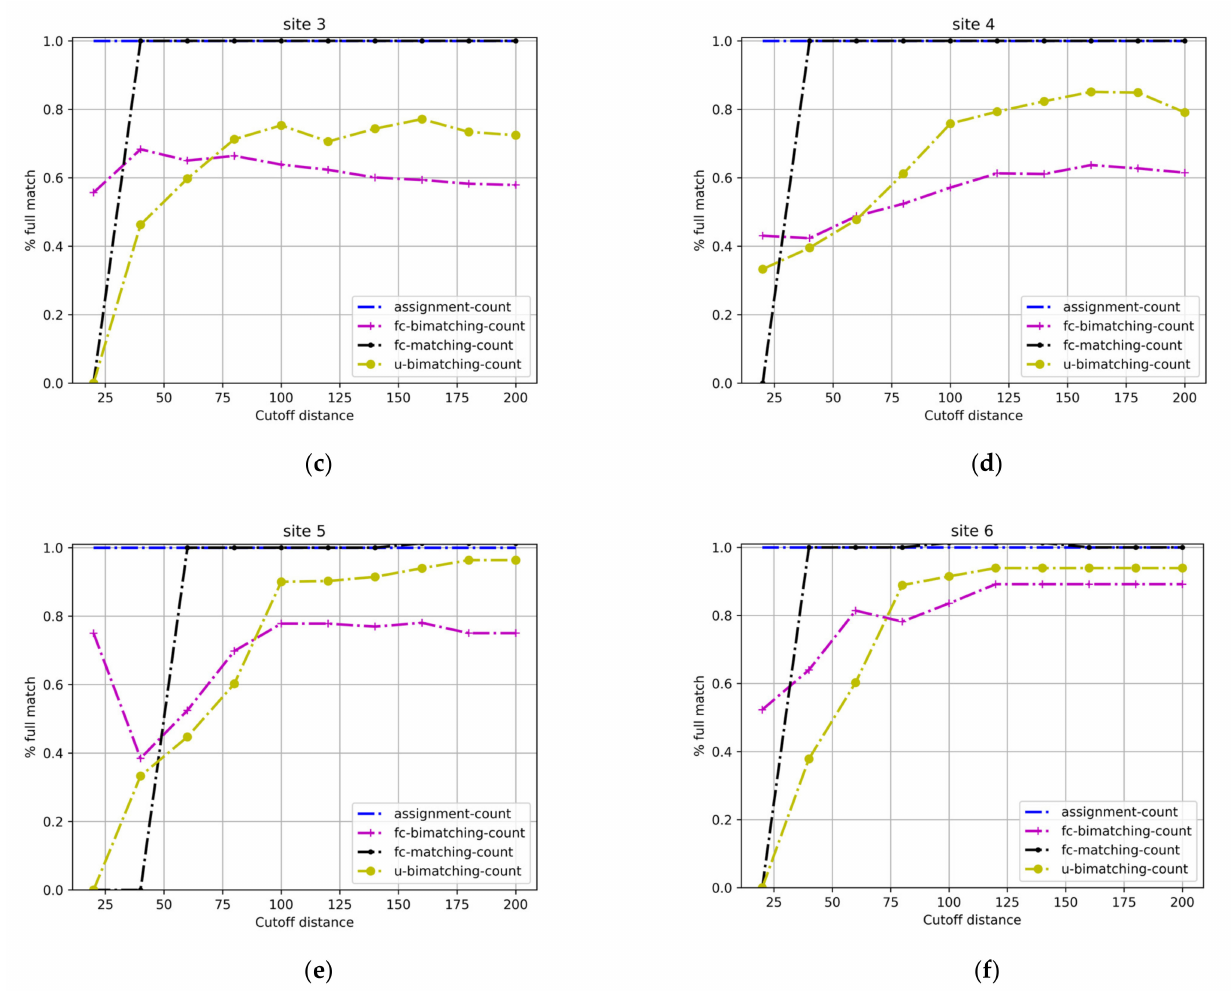
Figure 7. Percentage of full matches produced by tested optimized conflation models for the Santa Barbara dataset (OSM vs. TIGER). ( a – f ) Results for sites #1 through